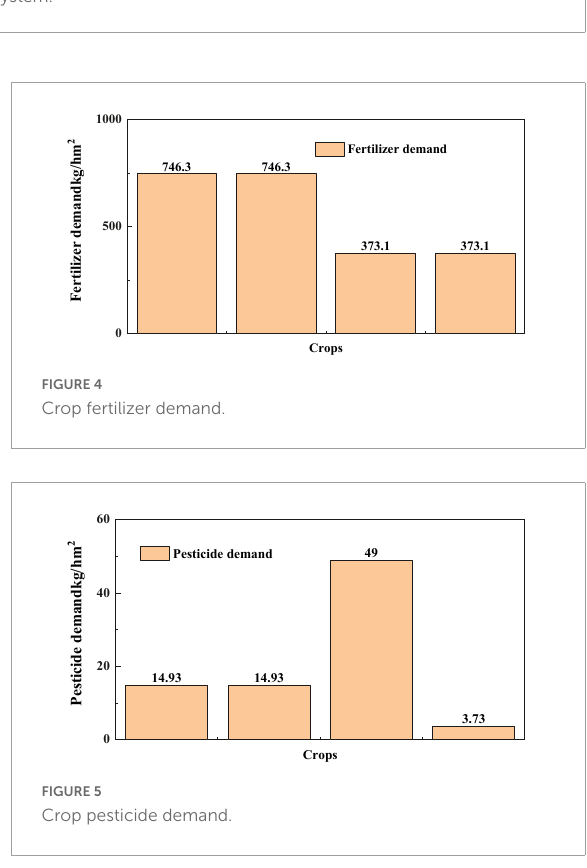
FIGURE5 Crop pesticide